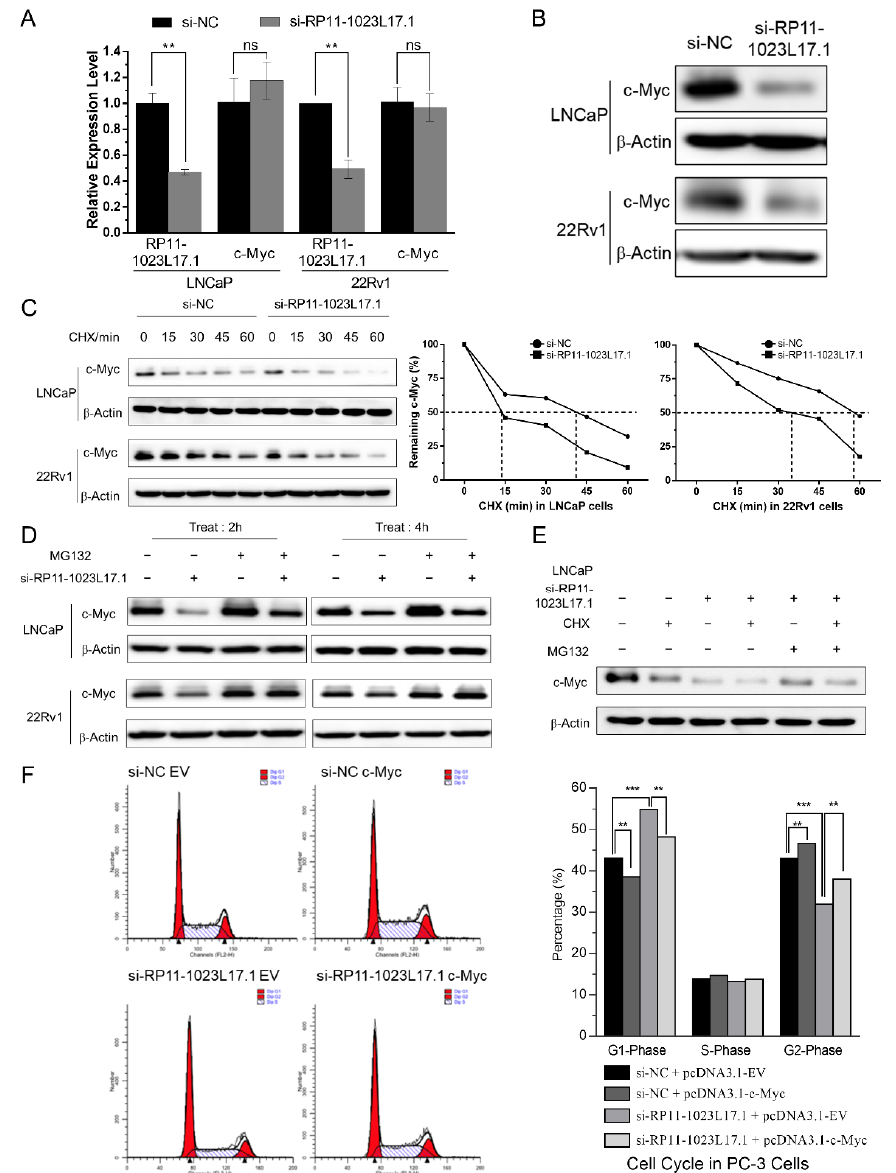
Figure 4. The enhancement of RP11-1023L17.1 on c-Myc protein stability may depend on proteasomal degradation. ( A ) The relative expression of RP11-1023L17.1 and c-Myc in LNCaP and 22Rv1 cells transfected with si-NC or si-RP11-1023L17.1 was measured by RT-qPCR. Data are presented as mean ± SD ( n ≥ 3). ( B ) Assessment of c-Myc expression by Western blotting in LNCaP and 22Rv1 cells transfected with si-NC or si-RP11-1023L17.1. β -actin was used as a loading control. ( C ) Assessment of c-Myc expression by Western blotting in LNCaP and 22Rv1 cells transfected with si-NC or si-RP11-1023L17.1, following treatment with 25 µ g/mL protein synthesis inhibitor cycloheximide (CHX) in a time series. ( D ) Assessment of c-Myc expression by Western blotting in LNCaP and 22Rv1 cells transfected with si-NC or si-RP11-1023L17.1, following treatment with DMSO or 10 µ M proteasome inhibitor MG132 for 2 h or 4 h. ( E ) Assessment of c-Myc expression by Western blotting in LNCaP cells transfected with si-NC or si-RP11-1023L17.1 following treatment with DMSO, 25 µ g/mL CHX and/or 10 µ M MG132 for 0.5 h. β -Actin was used as a loading control. ( F ) PC-3 cells co-transfected with EV or pcDNA3.1-MYC and si-NC or si-RP11-1023L17.1 were stained with PI, and the cell cycle distributions were evaluated by flow cytometry. ns p > 0.05, ** p < 0.001, and *** p < 0.0001. Data are presented as mean ± SD ( n ≥